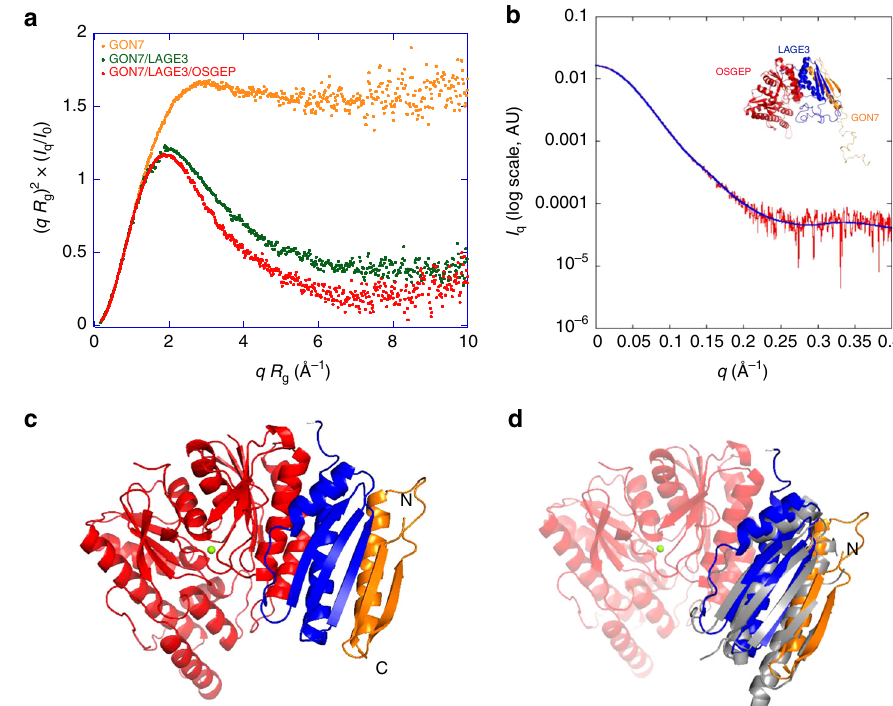
Fig. 5 Structure of the GON7/LAGE3/OSGEP complex. a Normalized Kratky plot of intensity scattering of GON7 (orange) and of the GON7/LAGE3 (green) and GON7/LAGE3/OSGEP complexes (red). q : scattering vector, R g radius of gyration, I q : scattering intensity, I 0 : scattering intensity at zero angle. b Experimental x-ray scattering curve of the GON7/LAGE3/OSGEP complex (red). The blue curve represents the calculated scattering curve for the corresponding crystal structure of the complex. This yielded a good fi t with the experimental data ( χ 2 = 0.33). The inset shows the BUNCH model. c Representation of the crystal structure of the GON7/LAGE3/OSGEP complex: GON7 (gold), LAGE3 (blue), OSGEP (red). The N and C-termini of GON7 are labeled. The crystal lacked density for GON7 beyond residue 50. The active site of OSGEP is highlighted by the Mg 2 + ion (green). d Superimposition of the yeast Gon7/Pcc1 complex (gray) onto GON7/LAGE3/OSGEP. GON7/LAGE3/OSGEP (same color code as in panel c